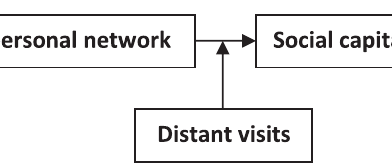
Figure 2. Conceptual model of the relationship between migration and social